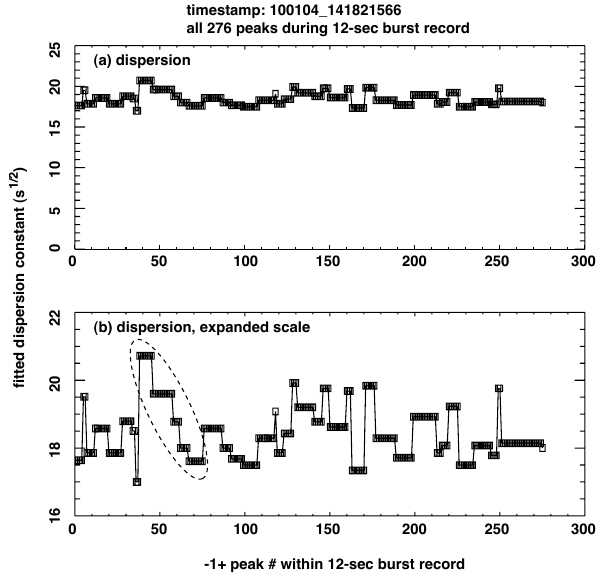
oval in Fig. 10) is now marked with asterisks. These high- resolution figure-of-merit plots show another perturbing ef- fect: oscillatory variation vs. dispersion constant. oscillation is due to interference between a limited